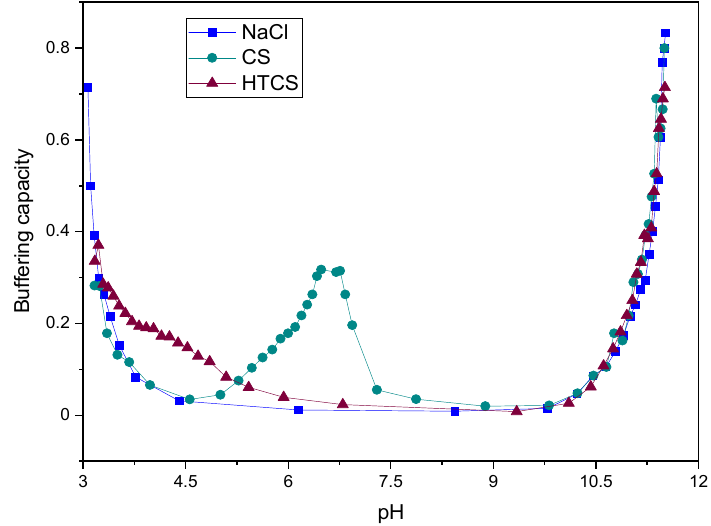
Figure 2. Buffering capacity curves of NaCl, CS, and HTCS in pH ranging from 3.0 to 11.0.